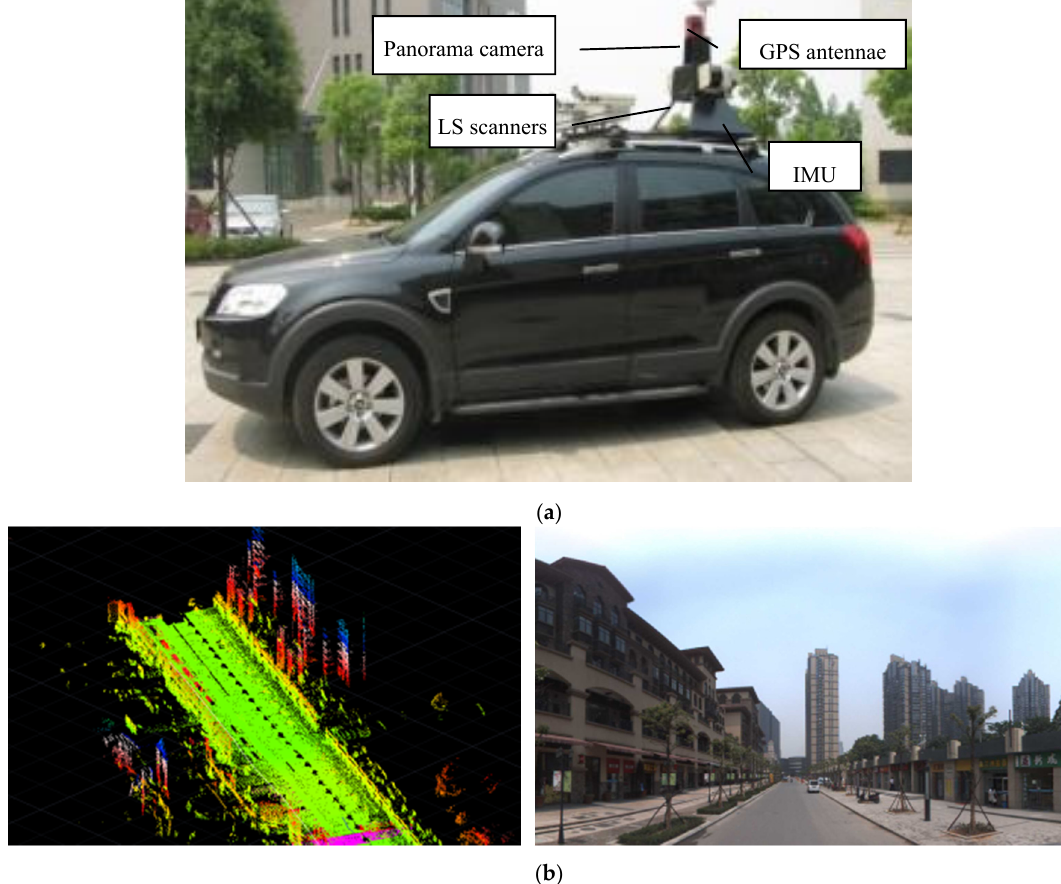
Figure 14. Vehicle-borne LIDAR scanning system and obtained point cloud data. ( a ) Vehicle-borne 3D LIDAR Scanning System; ( b ) Experiment dataset.